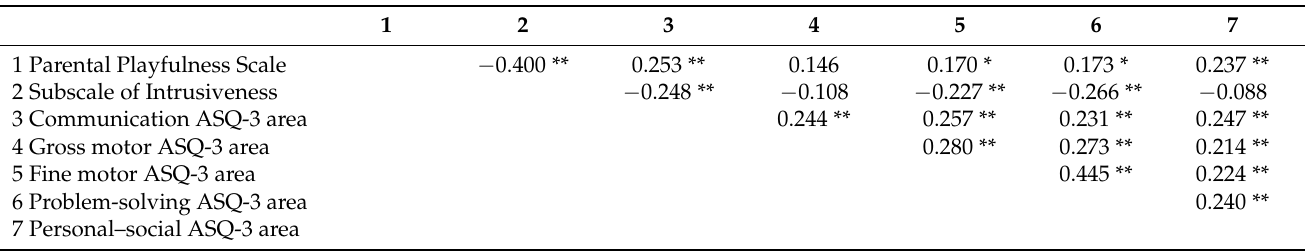
Table 2. Kendall’s correlations (T) between maternal playfulness, intrusiveness scores, and children’s ASQ-3 scores. Bootstrap BCa 95% CIs are shown within